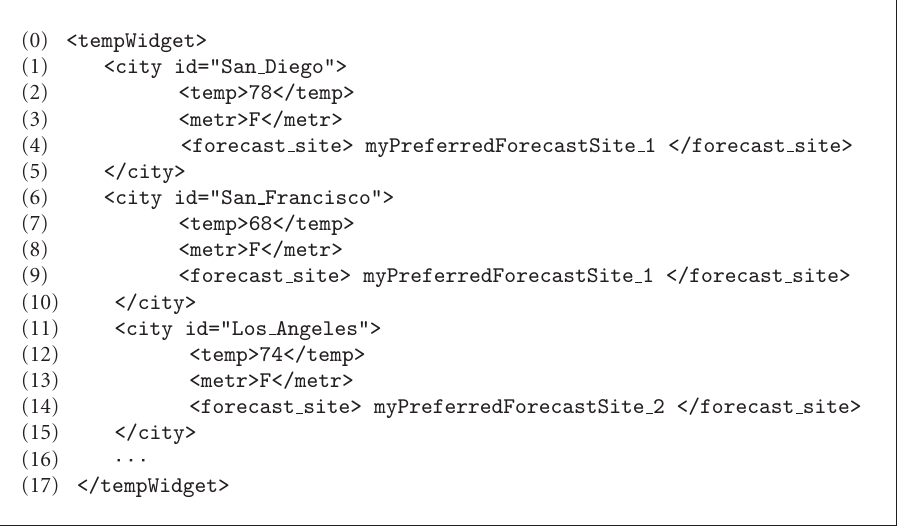
Figure 6: Contents gathered by the mobile